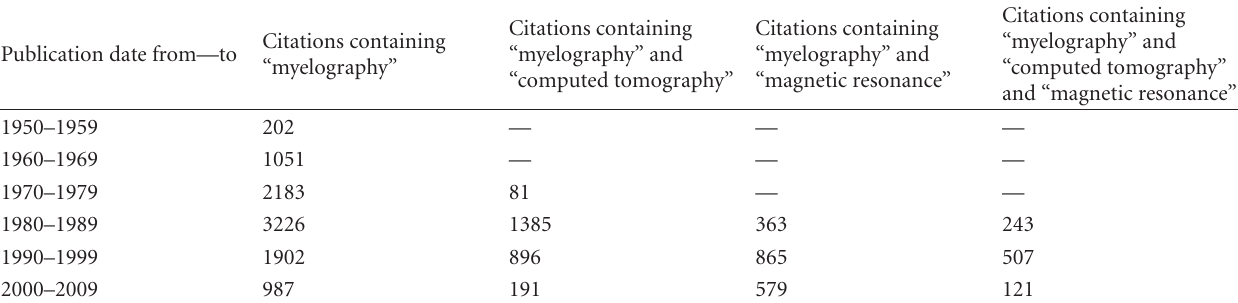
Table 1: Results of a PubMed search for “myelography” alone and in combination with “computed tomography” and/or “magnetic resonance”.